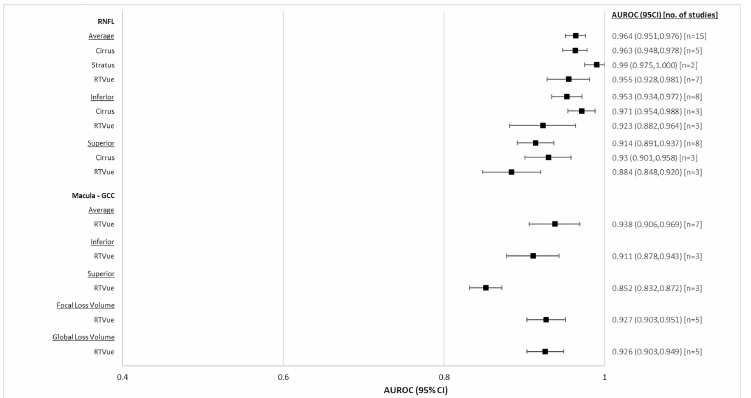
Fig 7. Forest plot of diagnostic accuraciesof RNFL and macular OCT parameters, moderate to severe glaucoma.